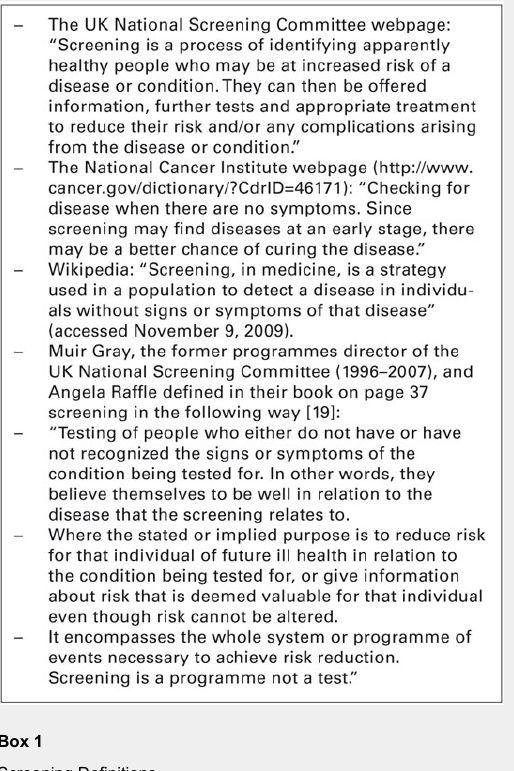
The balance of benefits, harm and quality (Adapted from